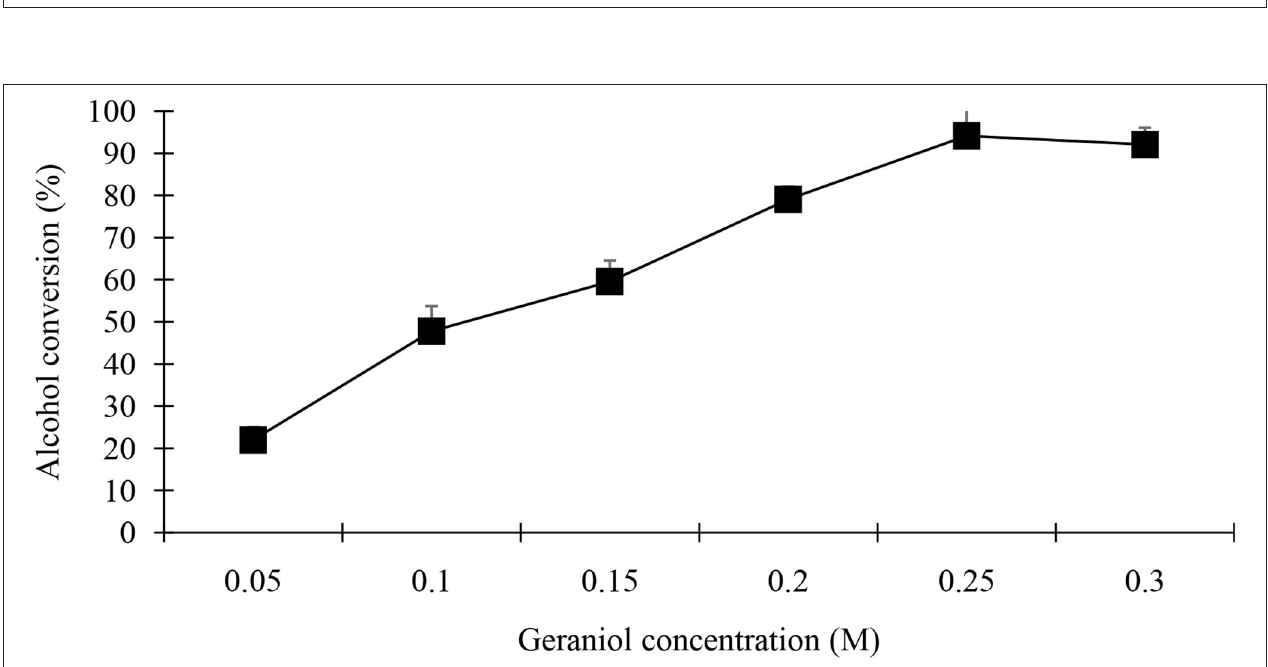
FIGURE 11 | Effect of butyric acid concentration on synthesis of geranyl butyrate ester was investigated. Various concentrations of acid investigated while the concentration of alcohol was kept constant at 0.25M. Reaction mixture containing 0.25g of black cumin seedling acetone powder in 5mL n -hexane. All reactions were carried out over a period of 48h at 37 ◦ C.